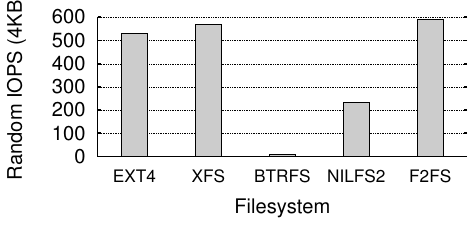
Figure 15. Random write using fsync() on internal eMMC. File size: 100MB; I/O size: 4 KB. [Samsung Galaxy S4, Android 4.2.2 (JB), /cache partition, EXT4].